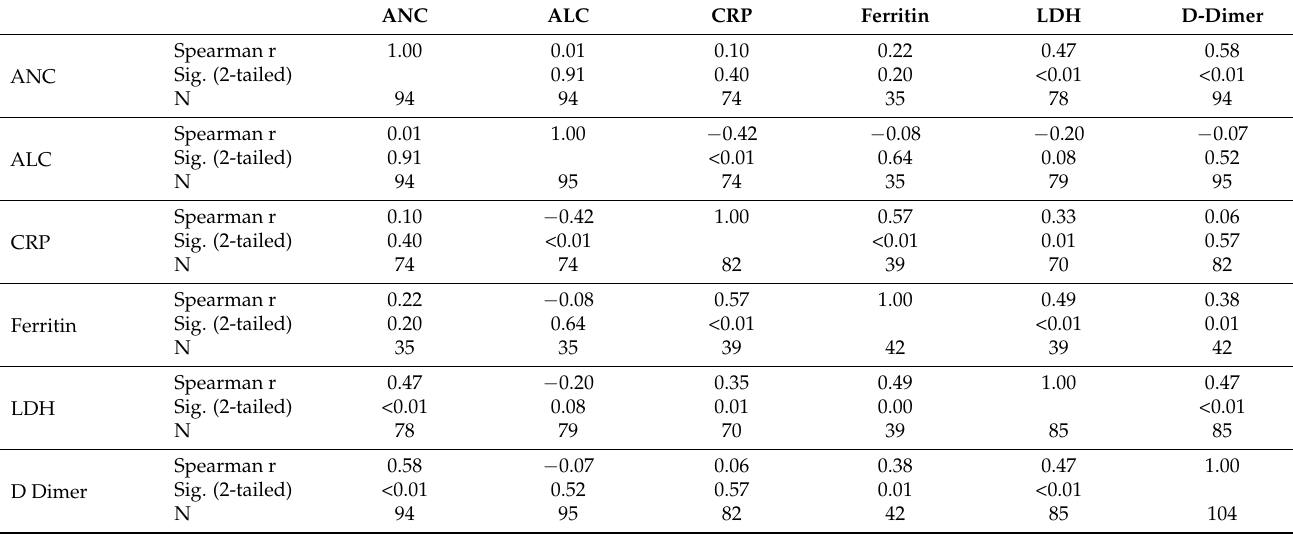
Table 3. Spearman correlation coefficients among absolute neutrophil counts, lymphocyte counts, and levels of